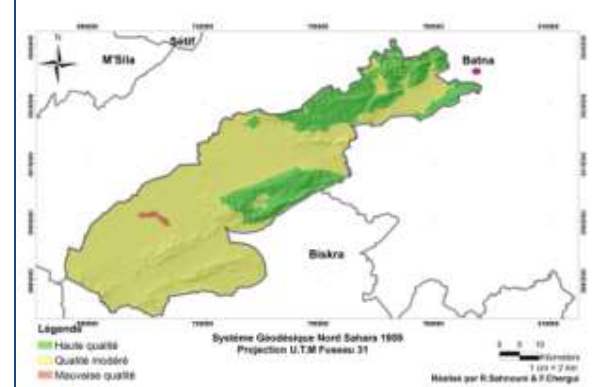
Figure 4. Vegetation quality map of the southern massif Belezma